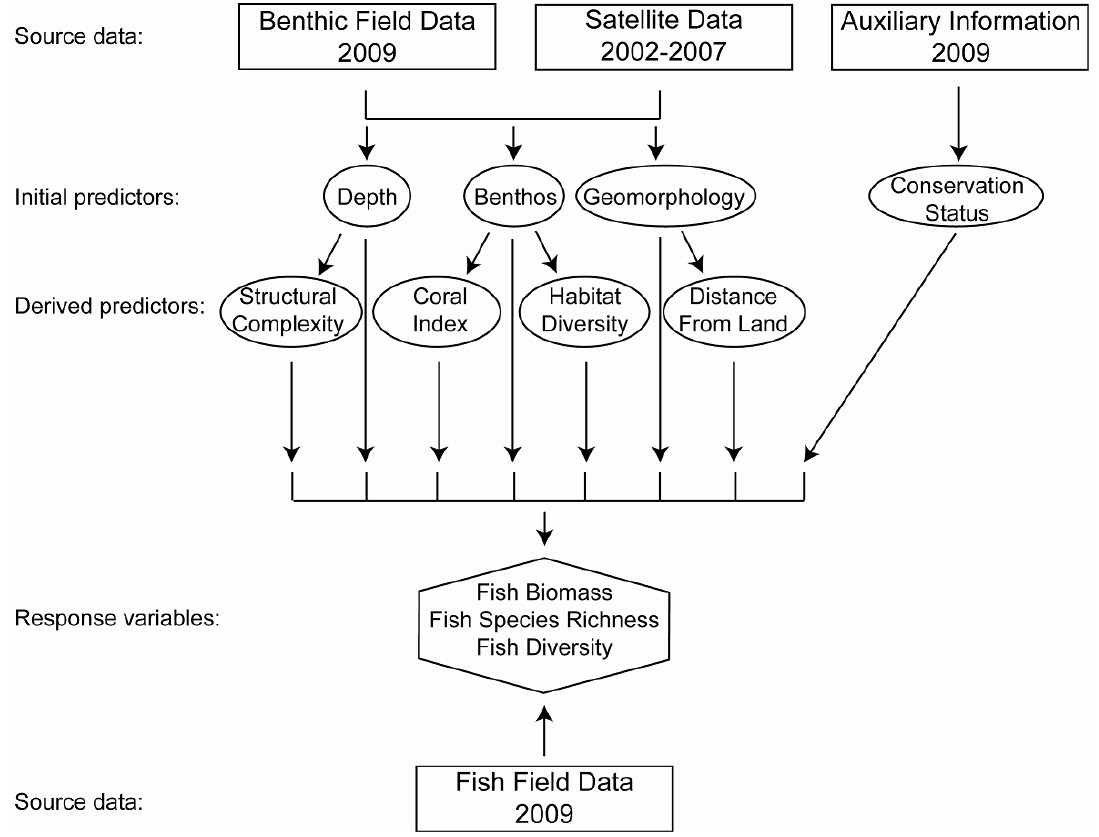
Figure 2. Flowchart describing the development of initial and derived predictors from source data, and their combination in predictive model development. Source data in boxes, predictors in circles, response variables in the